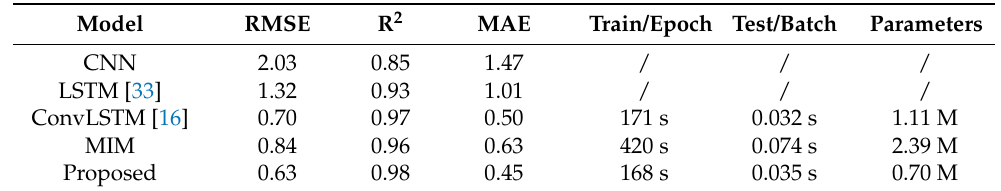
Table 3. Single-step duration prediction performance.